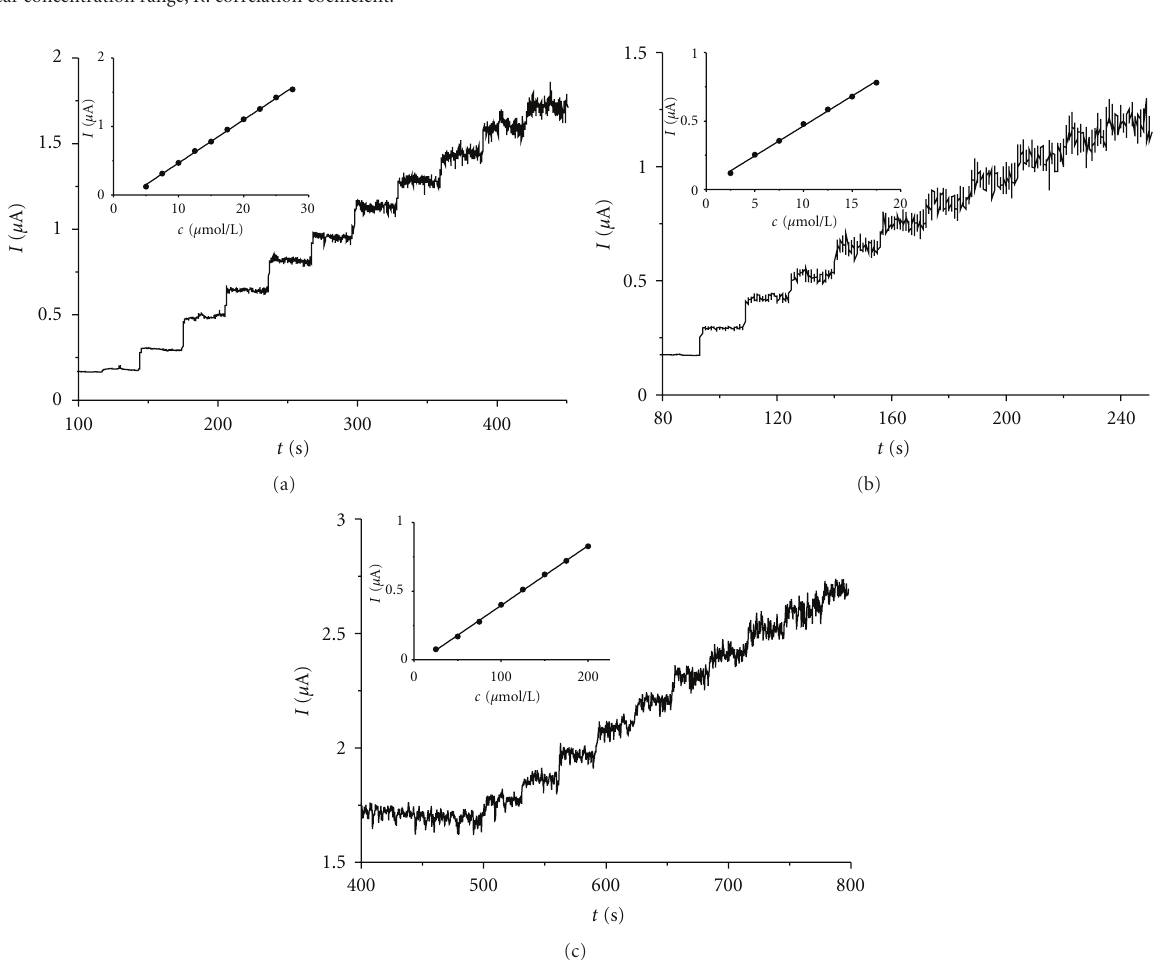
Figure 7: Amperograms and corresponding calibration curves (in insets) of rutin on unmodified (a), iron phthalocyanine modified (b) and ionic liquid modified (c) CPE at 500